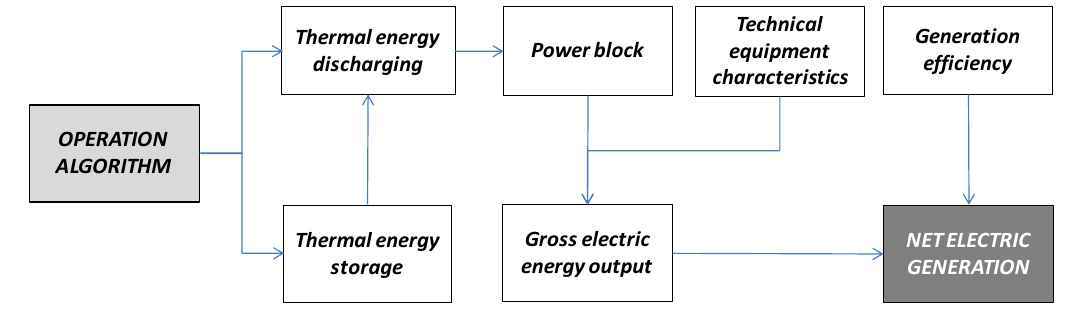
Figure 4. Functional unit for power block and net electric energy output models [14].